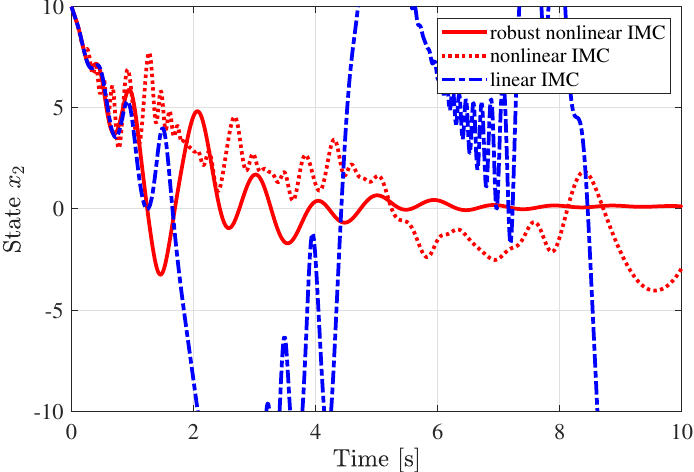
Figure 8. Controlled state x 2 achieved by the proposed IMC, the nonlinear IMC, and the linear